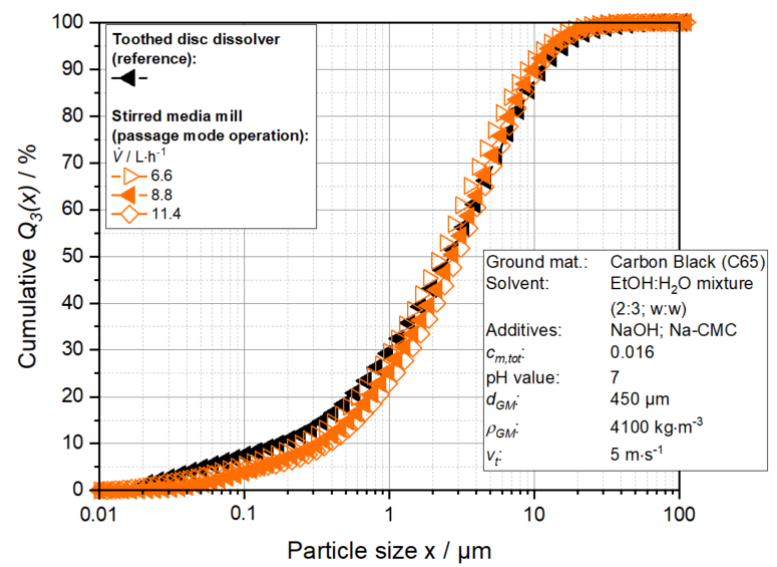
Figure 13. Comparison of resulting carbon black particle size distributions of the reference process and in a single-passage operation of a stirred media mill under variation of the product volume flow V ̇ and at a stirrer tip speed v t of 5 m·s −1 .